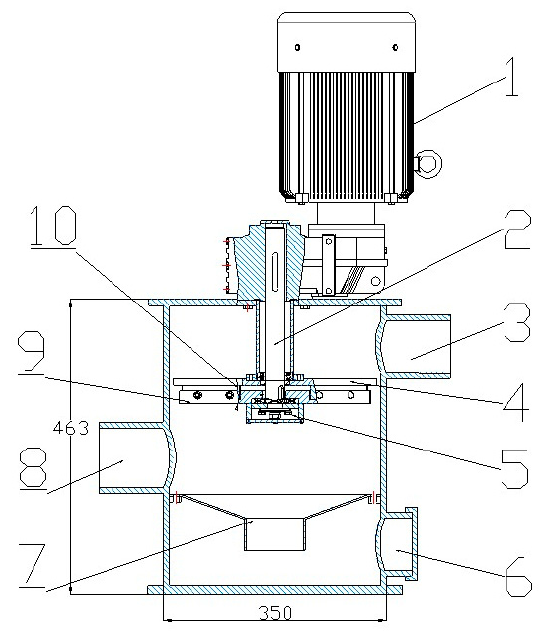
Figure 1. Structure chart of the crushing and impurity removal device. (1) Adjustable-speed motor, (2) transmission shaft, (3) outlet, (4) cutter head, (5) cross rotary cutter group, (6) impurities outlet, (7) funnel, (8) inlet, (9) cross tool holder, (10)